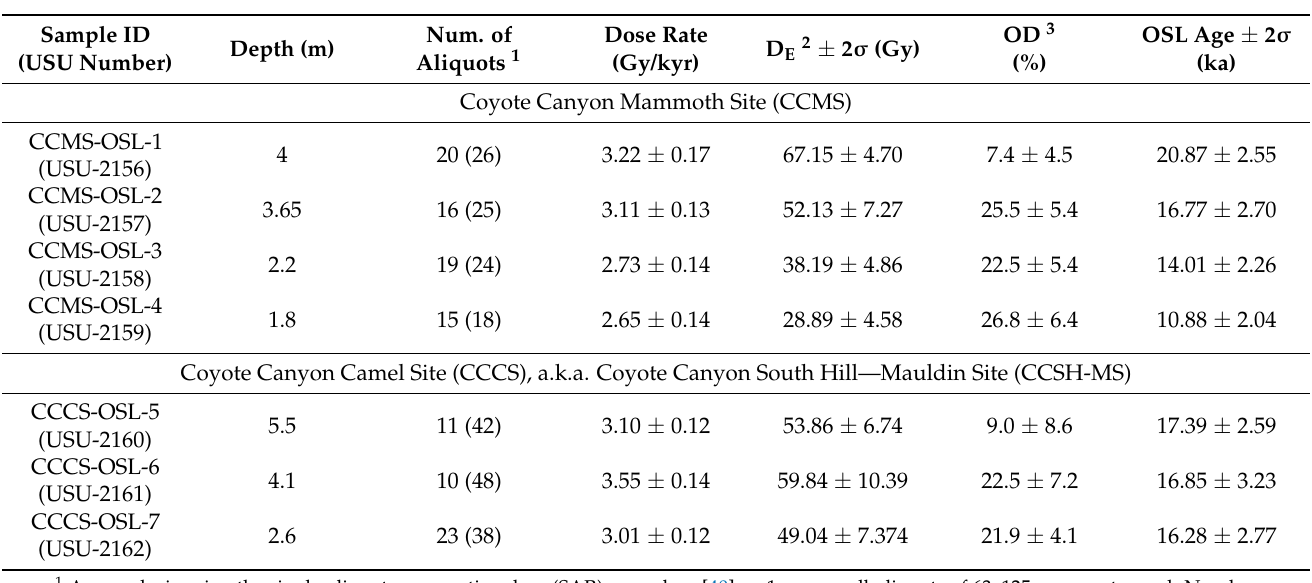
Table 4. Optically stimulated luminescence